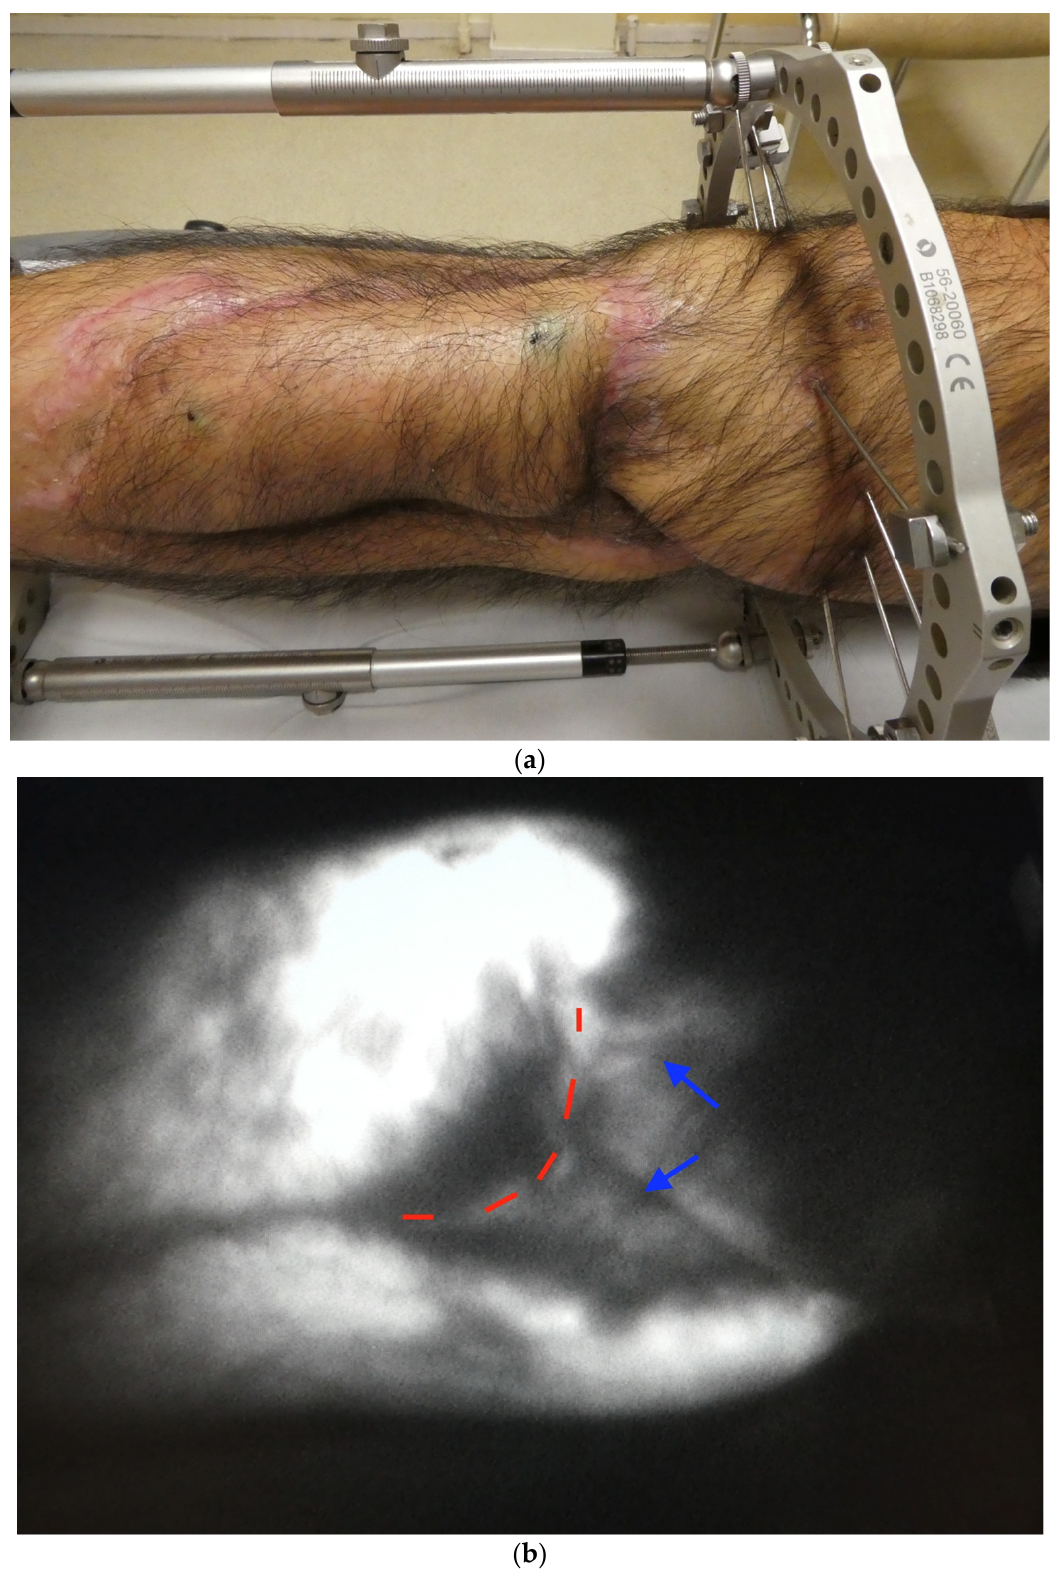
Figure 1. ( a ) Post-traumatic case, one year after ALT flap leg reconstruction. ( b ) ICG. Lymphatic channels (blue arrows) proximal to the flap (red dotted line) .